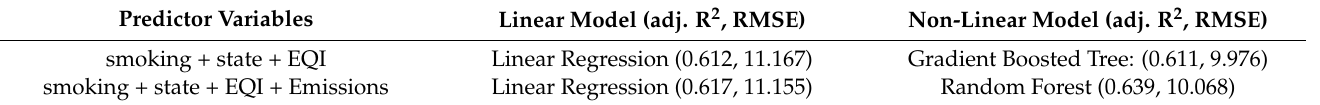
Table 7. Best performing Models: Variance Explained, Root Mean Squared Error.